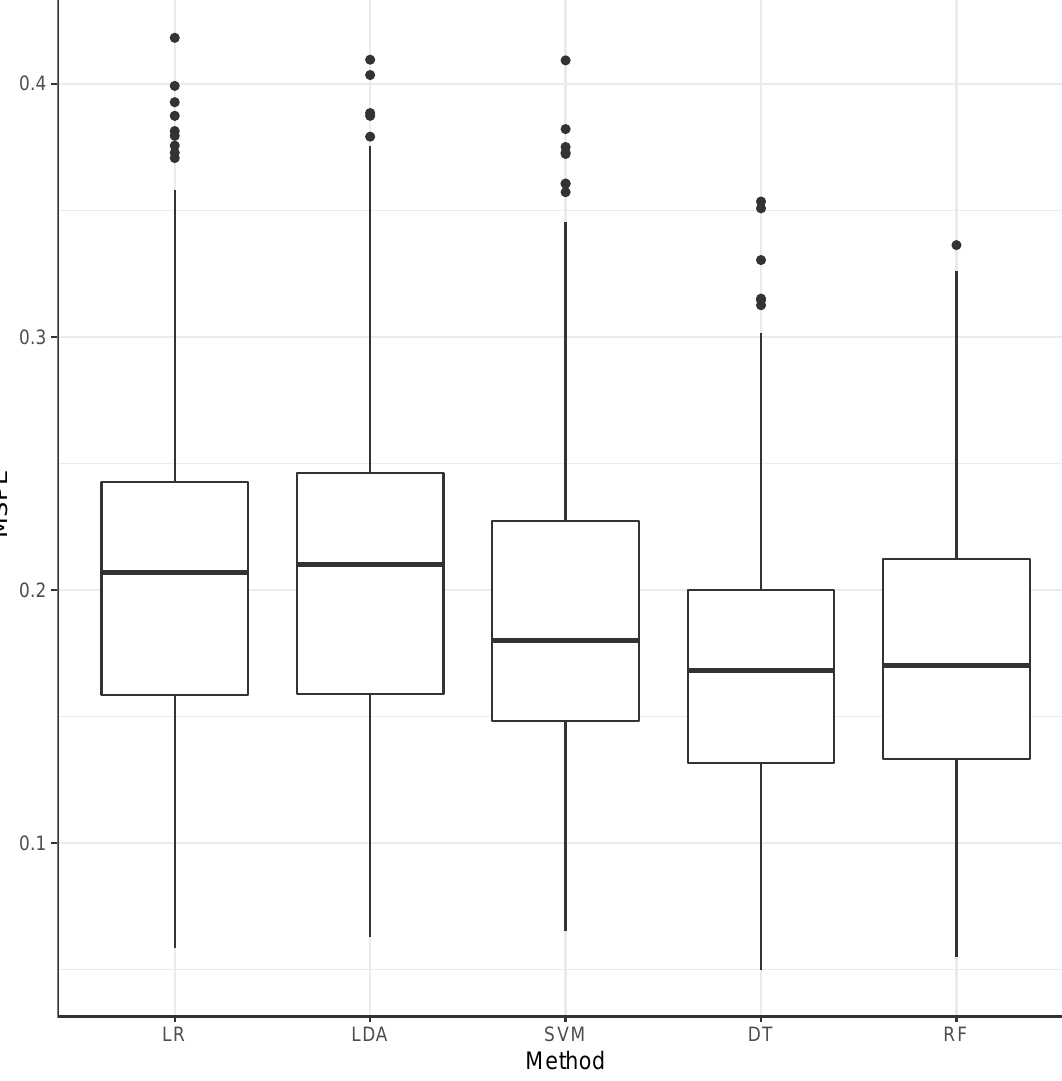
Figure 8. Spatial distributions of the MSPE for S3. Figure 9 presents the boxplots of the MSPE values for each of these two types of rain events and of all events. As expected, the stratiform category has smaller MSPE than the convective category. However, there are some outliers in stratiform. The convective cate- gory showed the largest error.